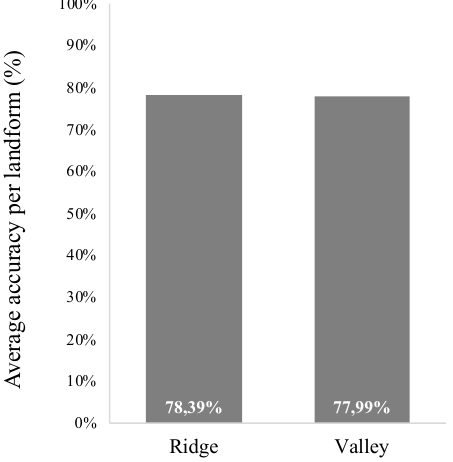
Figure 5. The average accuracy scores for each landform type for all participants presented in percentage. Note that here we did not round the numbers for the percent values presented in the bars (in white ink), if we round them, they would be both at 78%, which demonstrates the values were nearly identical.